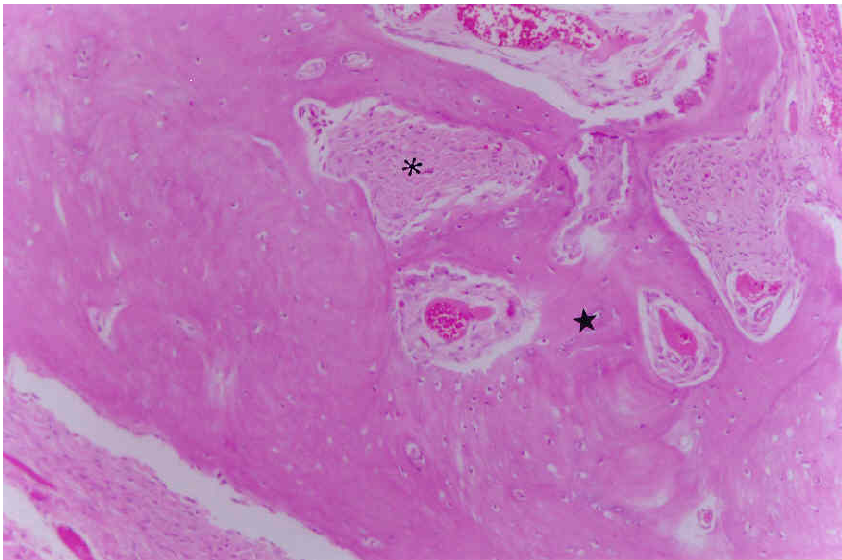
FIGURE 4 - Photomicrograph of the operated tympanic bulla of cat 8 of group A2. Bone tissue ( (cid:144) ) and connective tissue (*) are present at the osteotomy site, indicating intramembranous ossification. (HE,